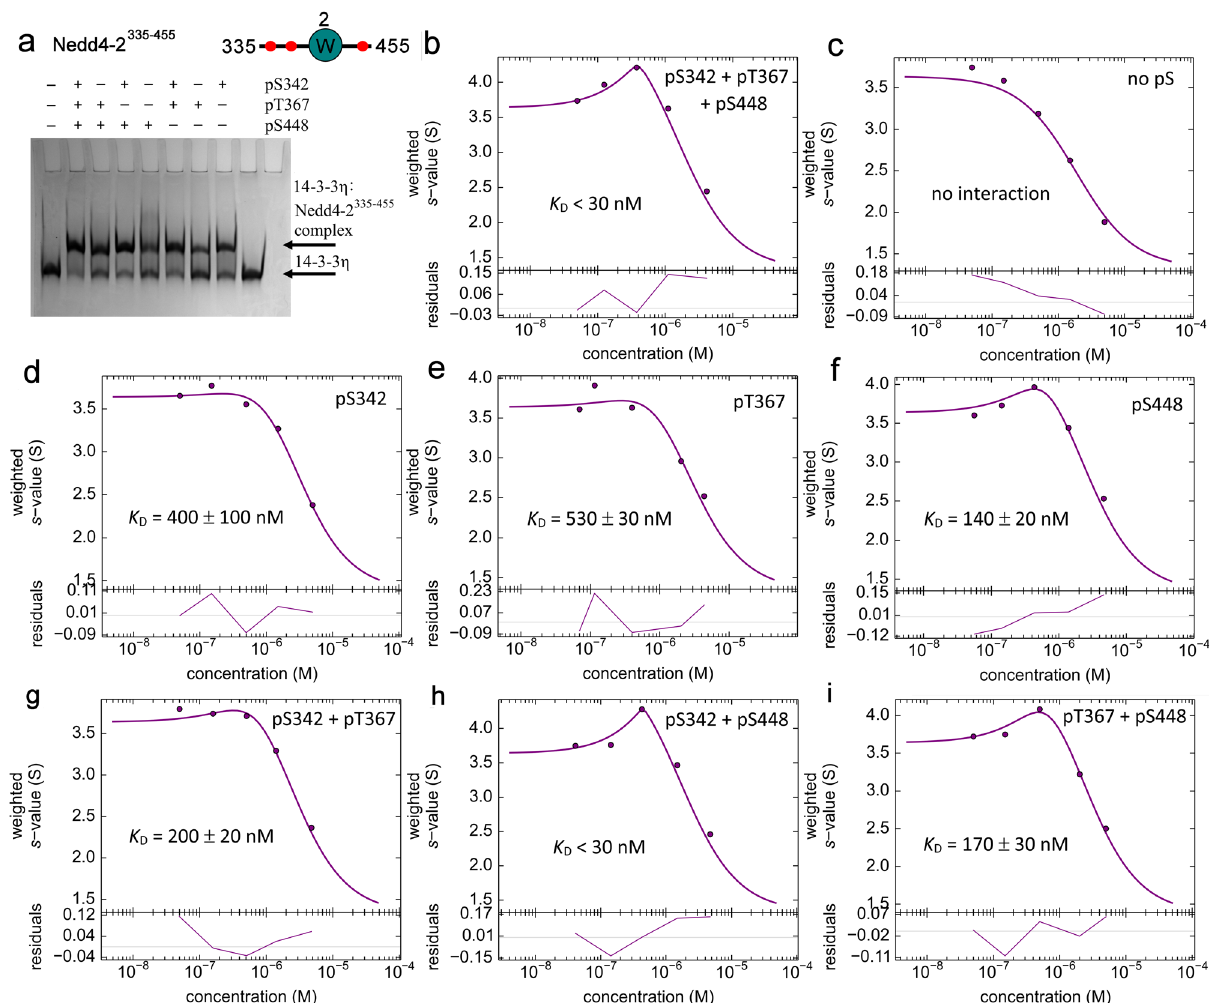
Fig. 3 Simultaneous phosphorylation of two 14-3-3 binding motifs pSer342 and pSer448 is required for tight complex formation between pNedd4- 2 335 – 455 and 14-3-3 η . a 12% Native TBE-PAGE showing the interaction between 14-3-3 η (240 pmol) and Nedd 335 – 455 variants without (no pS) or with one, two or three phosphorylation sites (120 pmol); 14-3-3 η protein alone was loaded on the penultimate lane. b – i Sedimentation velocity analytical ultracentrifugation analysis of the complexes between 14-3-3 η and pNedd4-2 335 – 455 variants showing the s w isotherms of 14-3-3 η and Nedd4-2 with all three phosphorylation sites pSer 342 + pThr 367 + pSer 448 ( b ), with no phosphorylation sites ( c ), with one phosphorylation site (pSer 342 ( d ), pThr 367 ( e ) and pSer 448 ( f )), or with two phosphorylation sites (pSer 342 + pThr 367 ( g ), pSer 342 + pSer 448 ( h ) and pThr 367 + pSer 448 ( i )). The isotherms of weight- averaged sedimentation coef fi cients were constructed by SV-AUC analysis of mixtures of 1 μ M 14-3-3 η with Nedd 335 – 455 variants (0.05 – 5 μ M). The c(s) distributions underlying the s w data points are shown in Supplementary Fig.